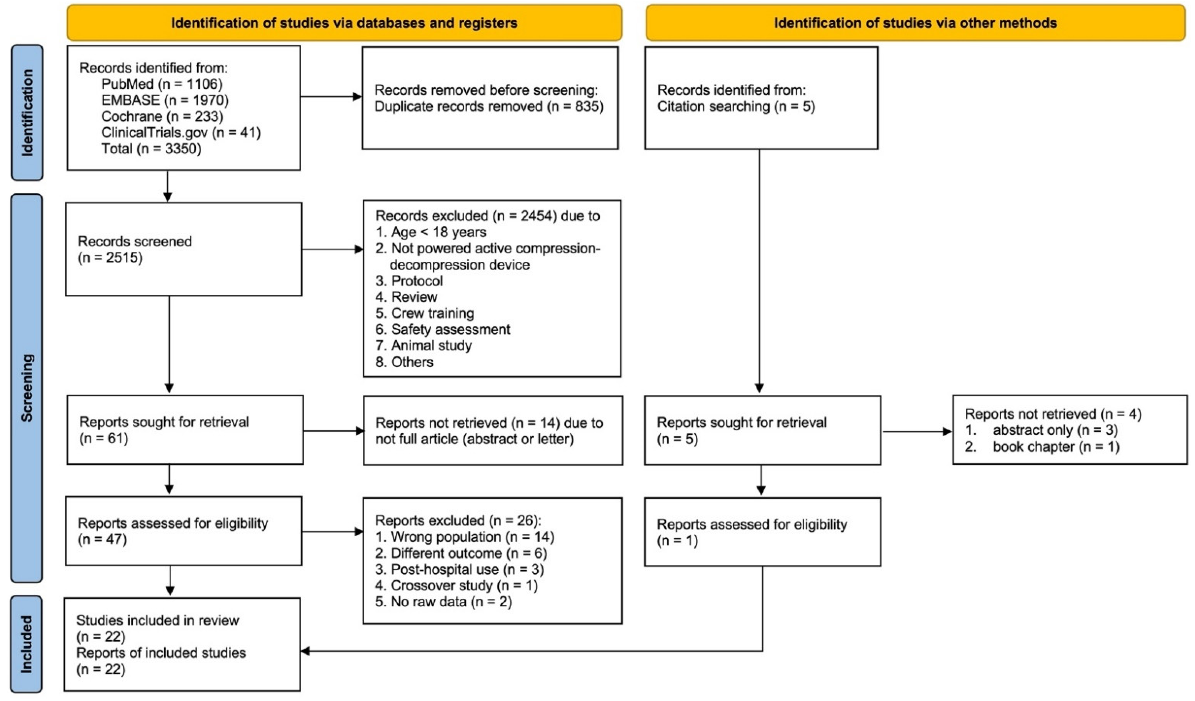
Figure 1. Flow diagram of preferred reporting items for systematic reviews and meta-analysis (PRISMA) 2020.